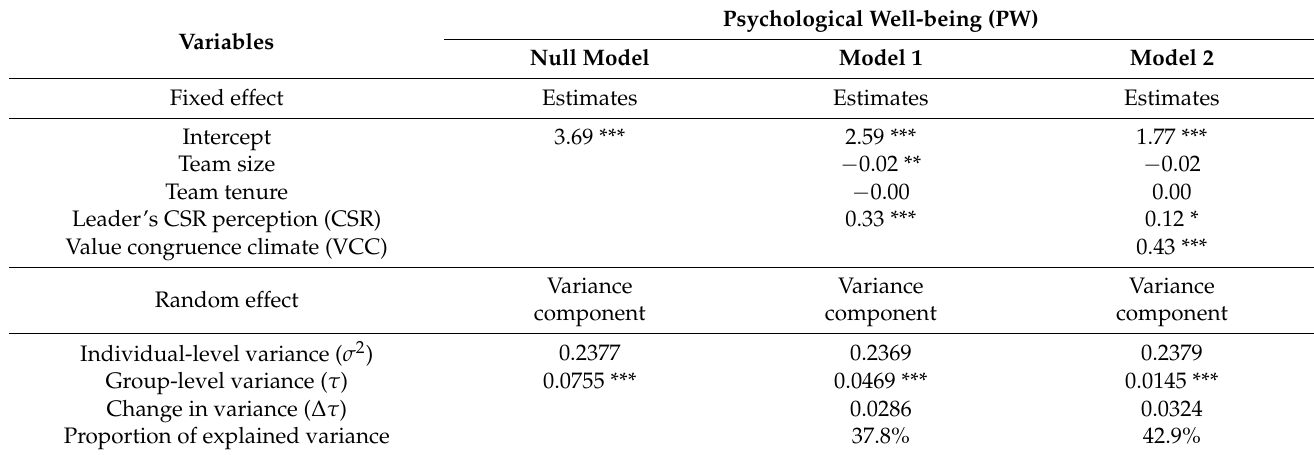
Table 4. Mediating effect of value congruence climate (Group